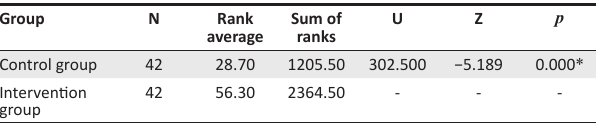
TABLE 6: Mann-Whitney U test on parent–child interaction. Group N